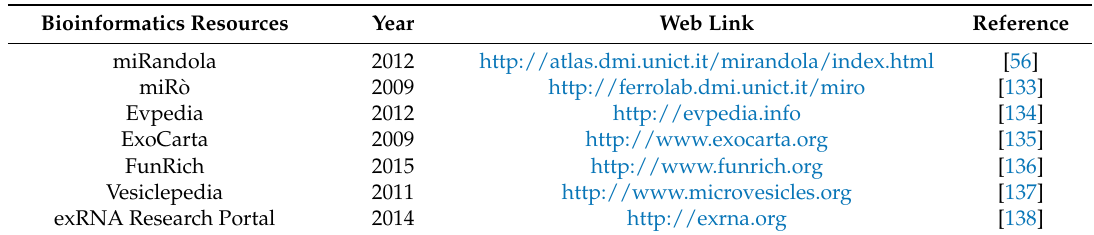
Table 1. List of analysis tools and databases for circulating extracellular miRNAs, web links and year of publication. Resources listed in the table have been described in the